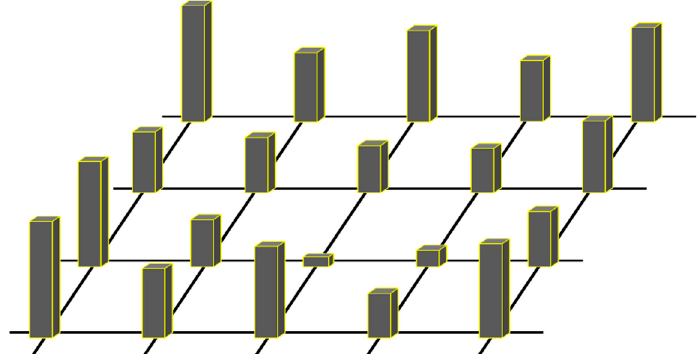
Figure 2. Concept of grid-post terrain.